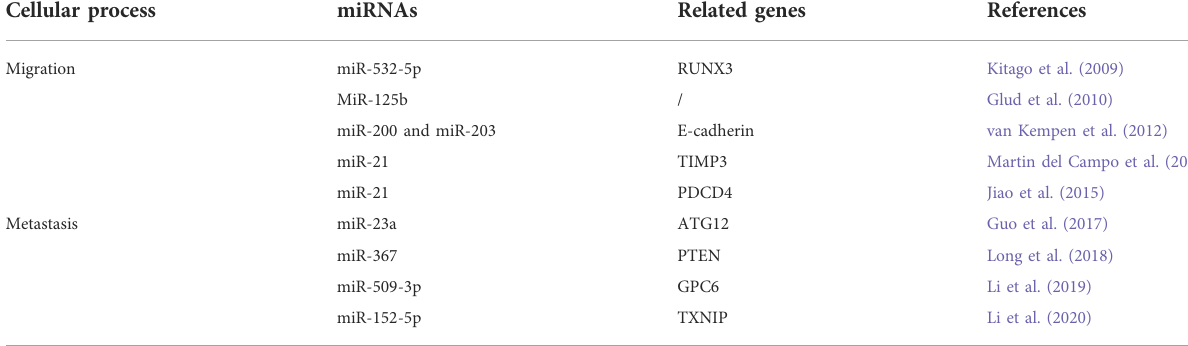
TABLE 5 Functional characterization of miRNAs in cell migration and metastasis of melanoma. Cellular process